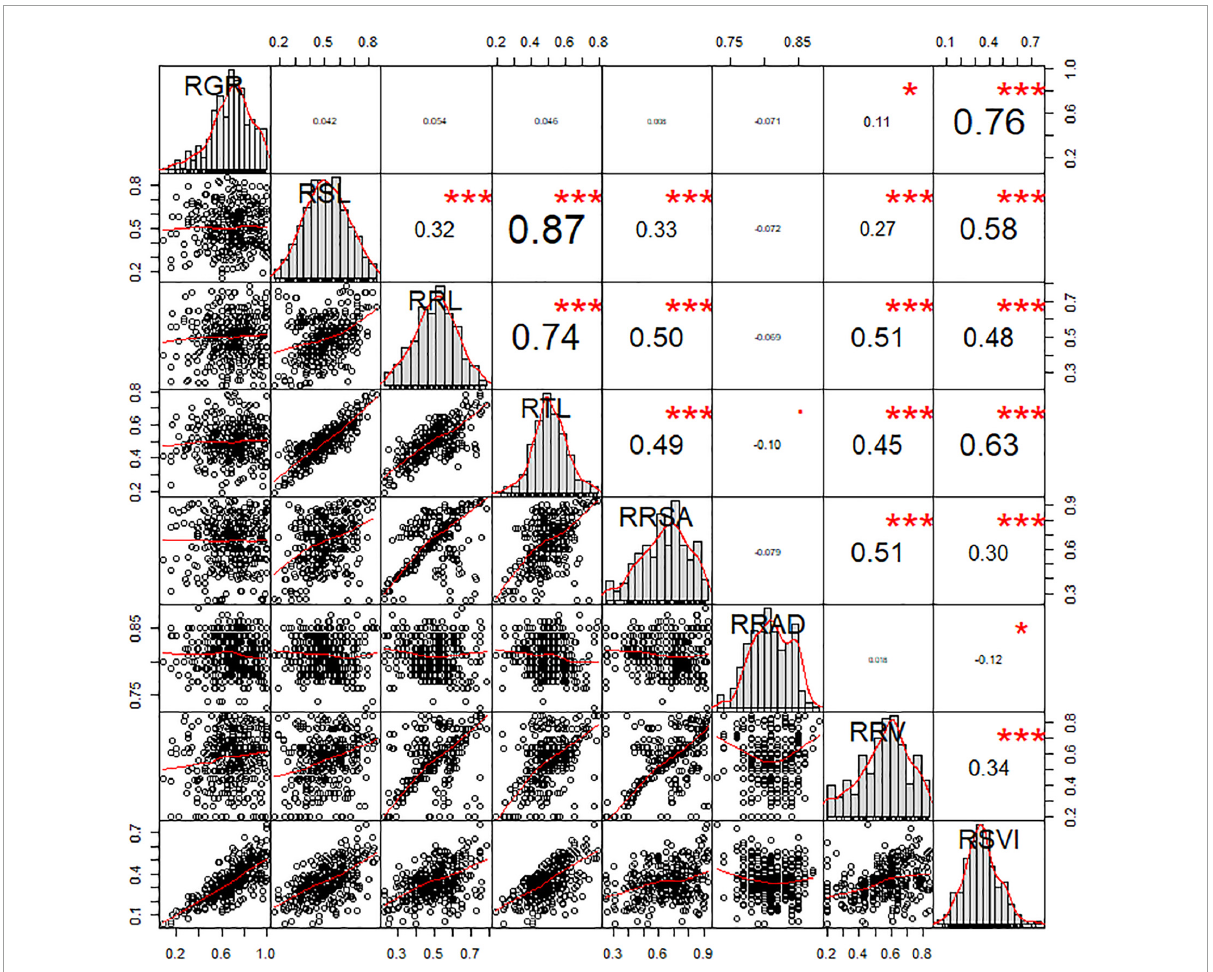
FIGURE1 Correlation analysis of the RIL population related to low-temperature tolerance traits. The frequency distribution of each trait is shown on a central diagonal in the form of a histogram. Scatter plots of between each pair of traits are shown in the areas below the diagonal, and numerical correlation coefficients between each pair of traits are shown in the areas above in the diagonal. ∗ and ∗∗∗ indicate significance at p < 0.05 and p < 0.001,